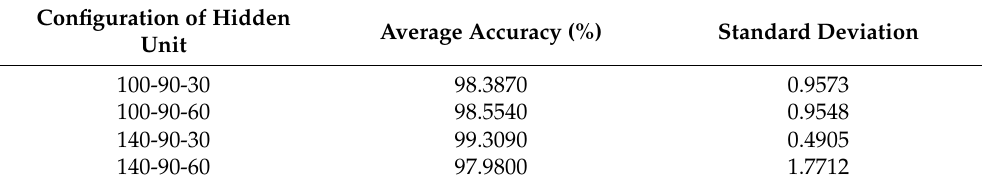
Table 4. The classification results according to changes in hidden units of the 1D CNN–GRU with the C4G3 * structure.